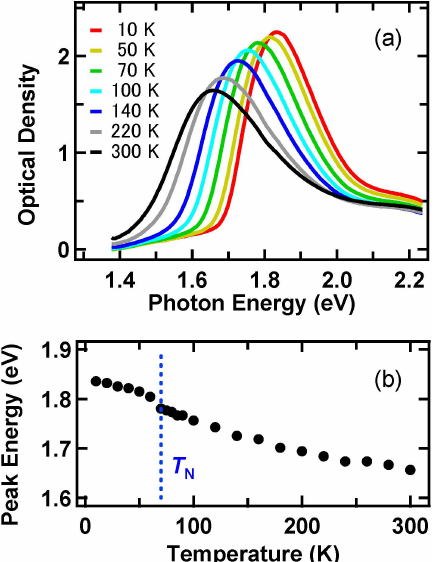
Figure 2. ( a ) Temperature dependence of the absorption spectrum in the YMnO 3 thin film. ( b ) Peak energy of the absorption band as a function of temperature. The vertical dashed line indicates the Néel temperature.